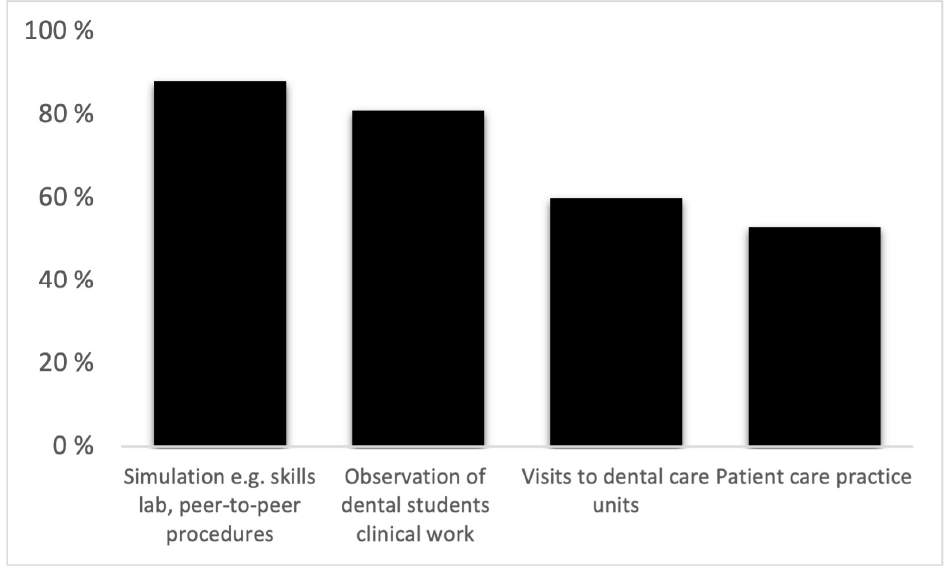
Figure 1. Elements proposed for the preclinical study phase of the dental curriculum (n = 110).